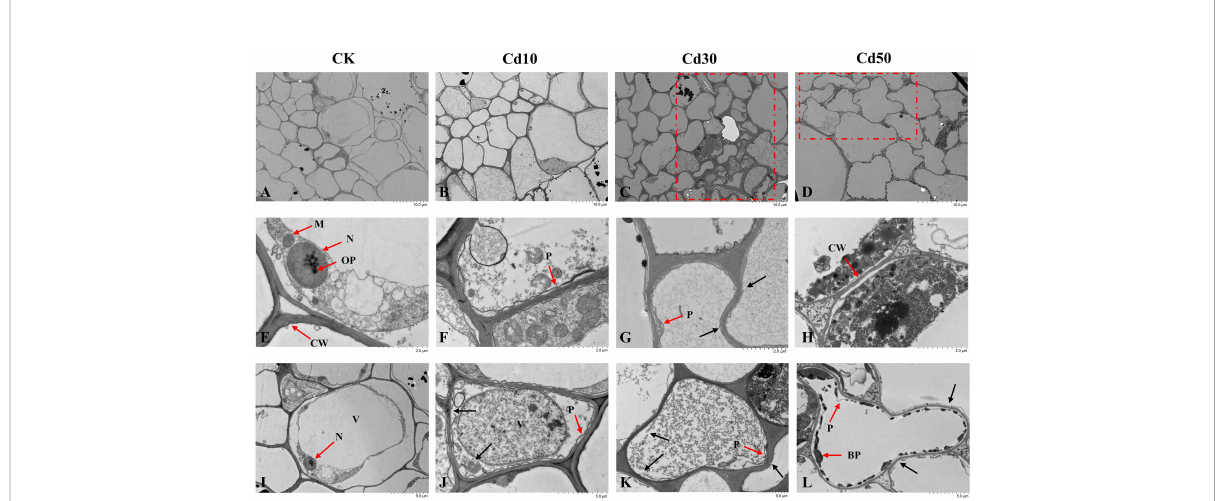
FIGURE 6 The ultrastructural examinations of root cells under different cadmium treatments. (A, E, I) Normal cell morphology, organelles, plasma membranes, and cell walls in controls. (B – D) Cell morphology under different Cd concentrations of treatments. (F – H, J – L) Damages induced by Cd in cell morphology, organelles, plasma membranes, and cell walls. CK, Cd10, Cd30, Cd50 indicates the Cd concentration 0 mg/L, 10 mg/L, 30 mg/L, and 50 mg/L, respectively. BP, black precipitates; CW, cell wall; M, mitochondria; N, nucleus; OP, osmiophilic particles; P, plasmolysis; V, vacuole. The red box shows the cell deformation. The red arrow points to the organelle or cellular content corresponding to the letters. The black arrow indicates the damaged